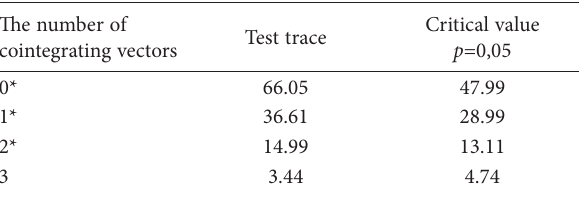
Table 2. Occurrence of correlations between the analyzed